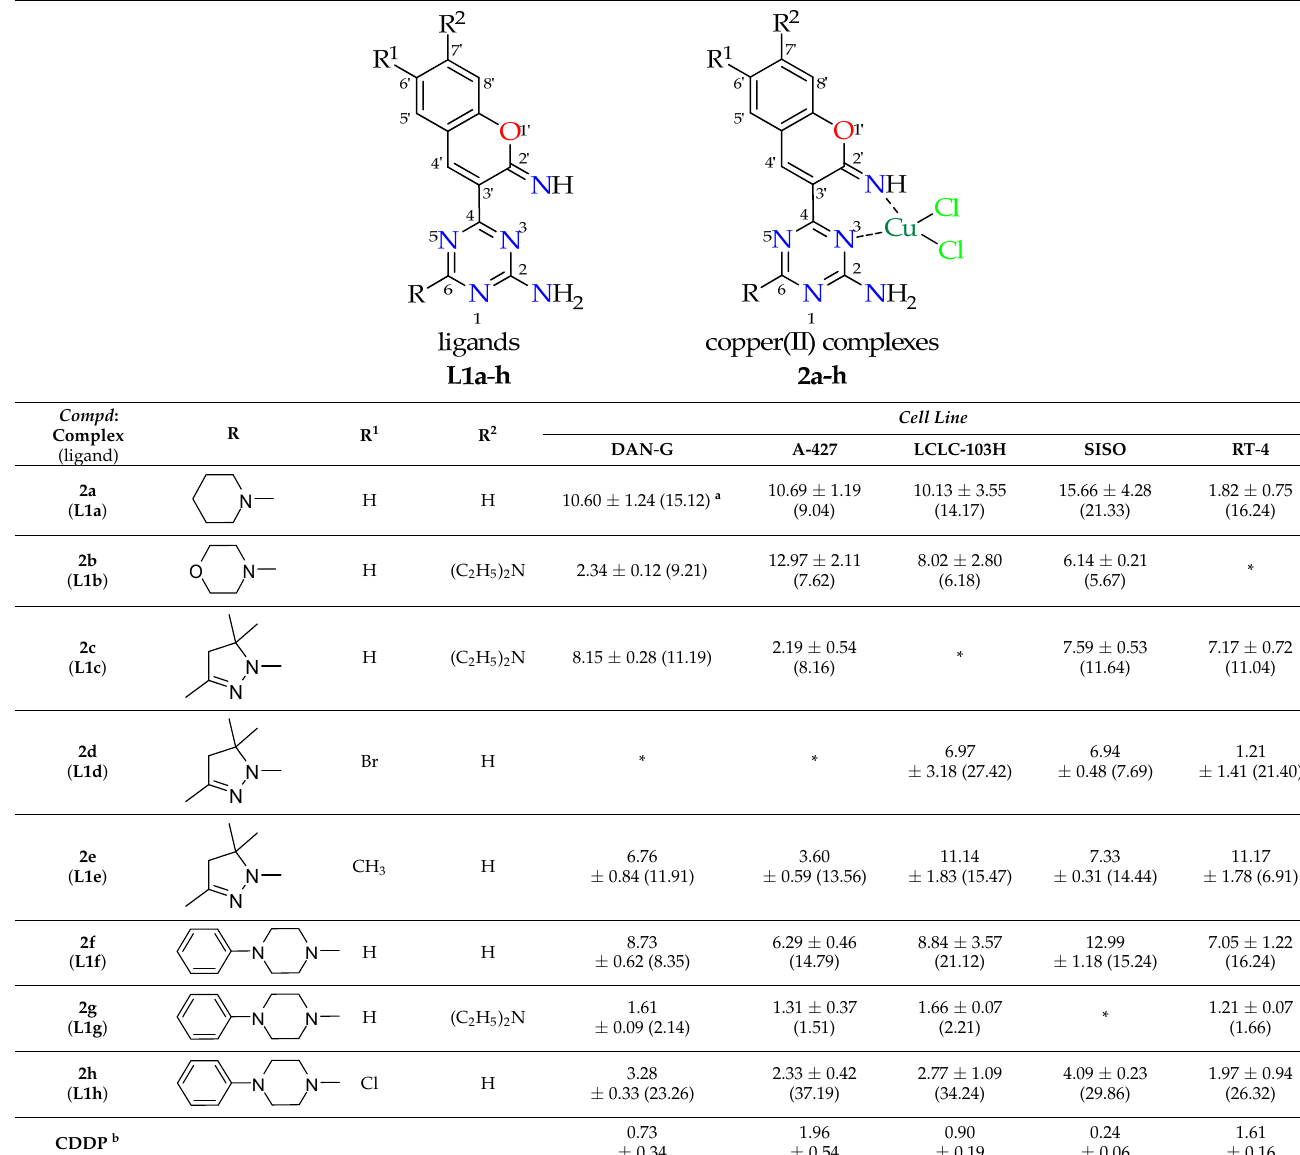
Table 1. IC 50 ( μ M) values of copper(II) complexes of 2-imino-2 H -chromen-3-yl-1,3,5-triazines 2a-h , their corresponding ligands L1a - h and reference compound in five human cancer cell lines after 96 h a.